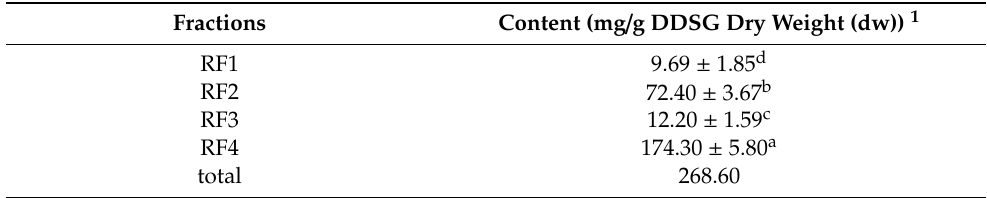
Table 1. Content of melanoidins in four fractions obtained by alkaline solution (RF2 and RF4)